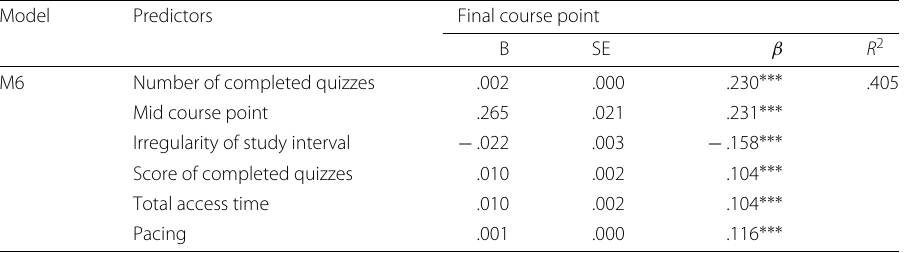
Table 6 Hierarchical regression analysis results on the final course point